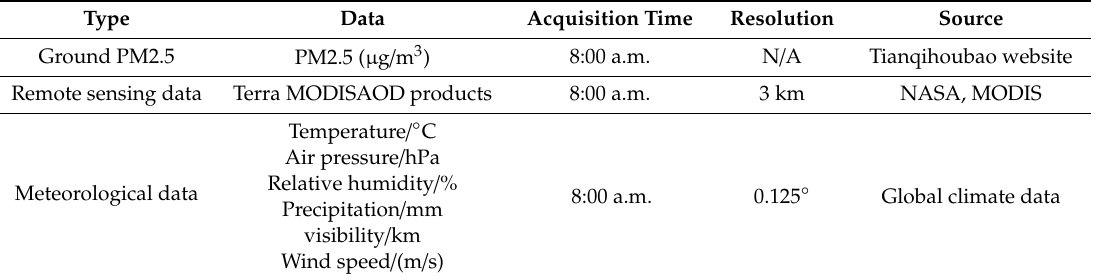
Table 1. Related parameters of data